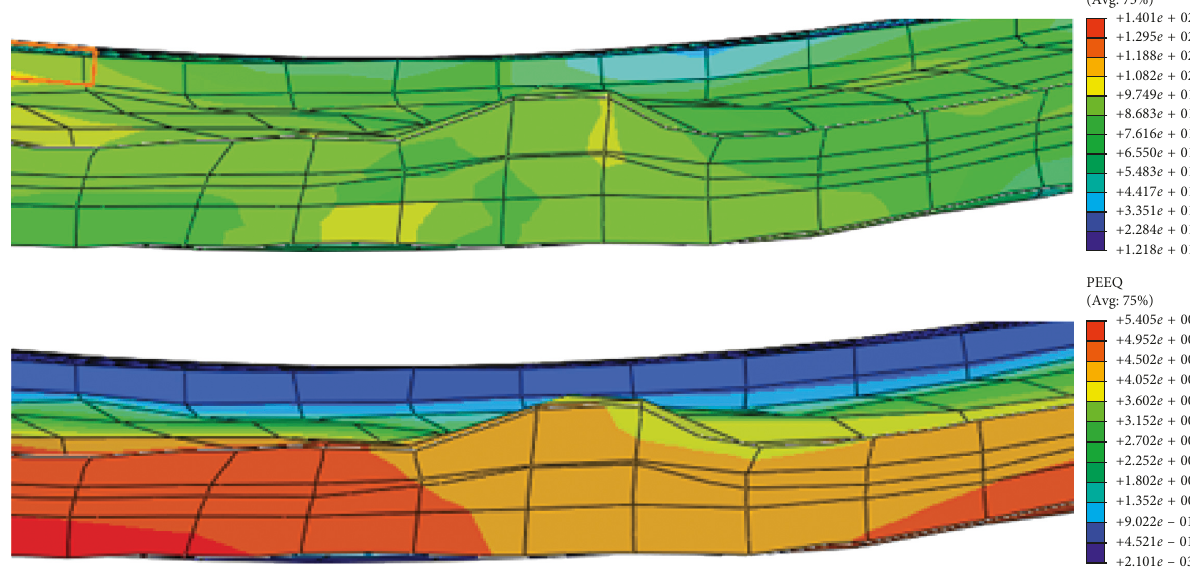
Figure 12: Mises stress diagram and equivalent strain diagram of the longitudinal ribs ( α � 22 ° , Ψ � 50%, and f � 180mm/min).